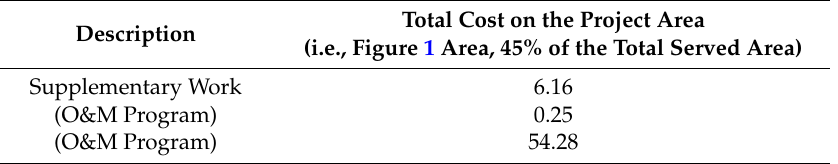
Table 9. Costs in game r A2,1